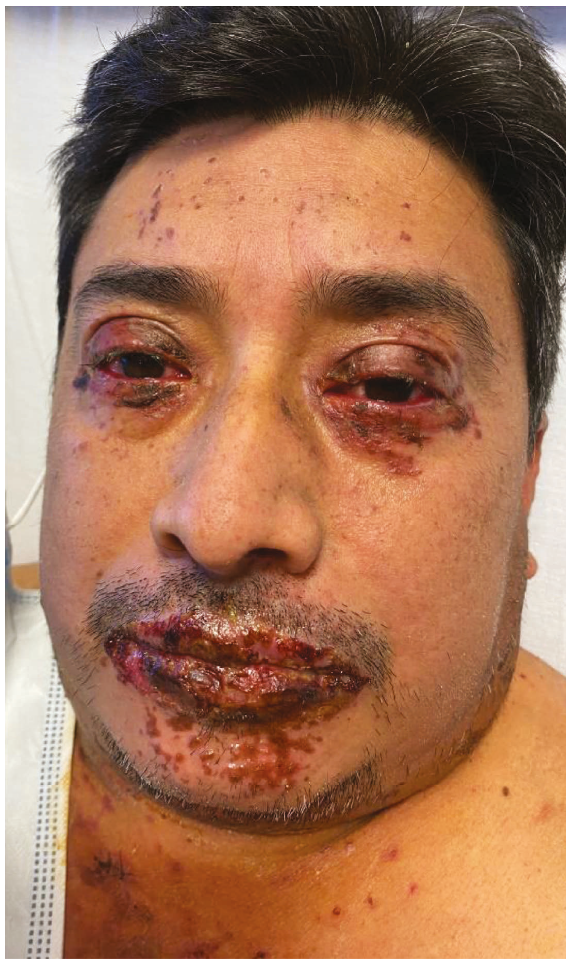
Figure 1: Mucocutaneous involvement in the initial presentation.